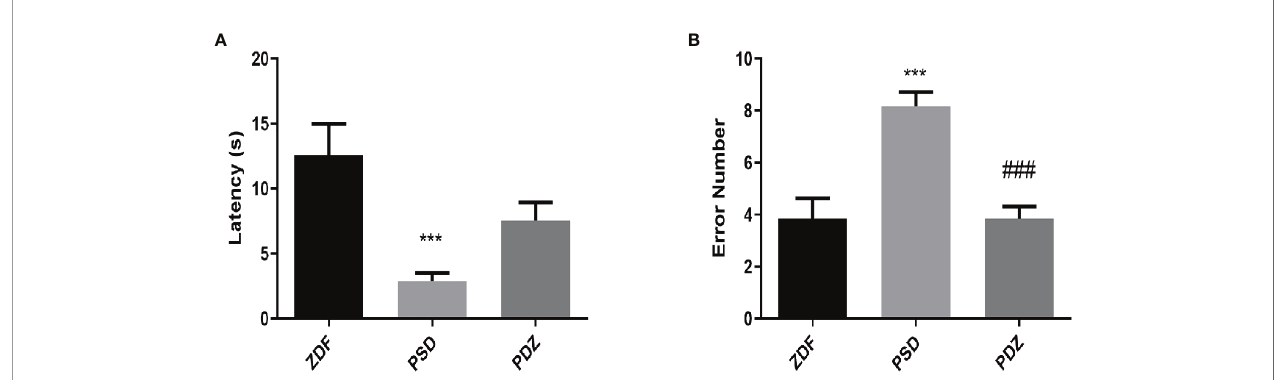
FIGURE 4 | Effect of ZBPYR on cognitive impairment in the passive avoidance test. The latency (A) and error number (B) were assessed. Bars represent the mean ± SEM of 6 rats per group. *** P < 0.001, PSD group vs. ZDF group; ### P < 0.001, PDZ group vs. PSD group.